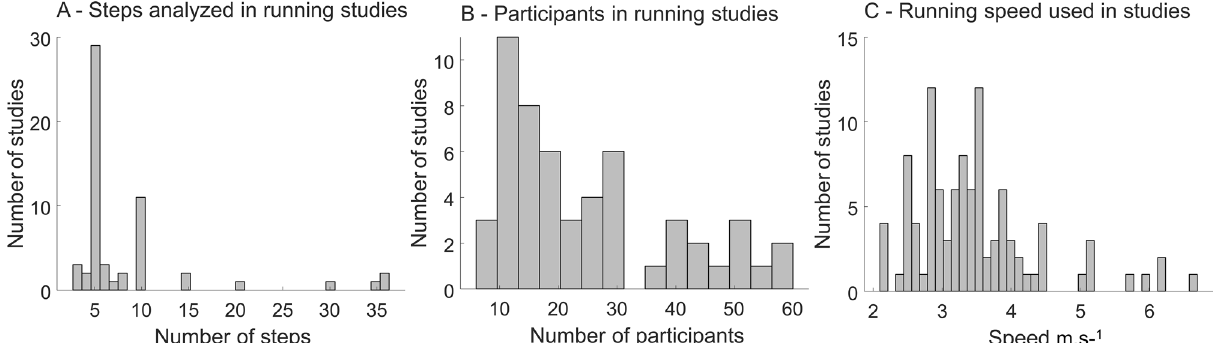
Figure 1. Distribution of running biomechanics studies describing the number of steps ( A ), participants ( B ), and running speed ( C ) from 2000 until present days. In total 60 studies were included in a short literature review (see Supplementary File 1). Some studies were not included in the plots to maximize visualization quality: In ( A ) Wouda et al. (2018) 43 reported around 200 steps in their analysis. In ( B ) Bredeweg et al. (2013) 44 and Stiffler-Joachim et al. (2019) 45 reported 170 and 210 participants, respectively. In ( C ) Stiles et al. (2013) 46 reported a running cadence of 130–140 steps/min, respectively 145–160 steps/min, as well as Morin et al. (2011) 47 , Rowlands and Stiles 48 (2012) and Pollard et al. (2018) 49 used the preferred running speed of the